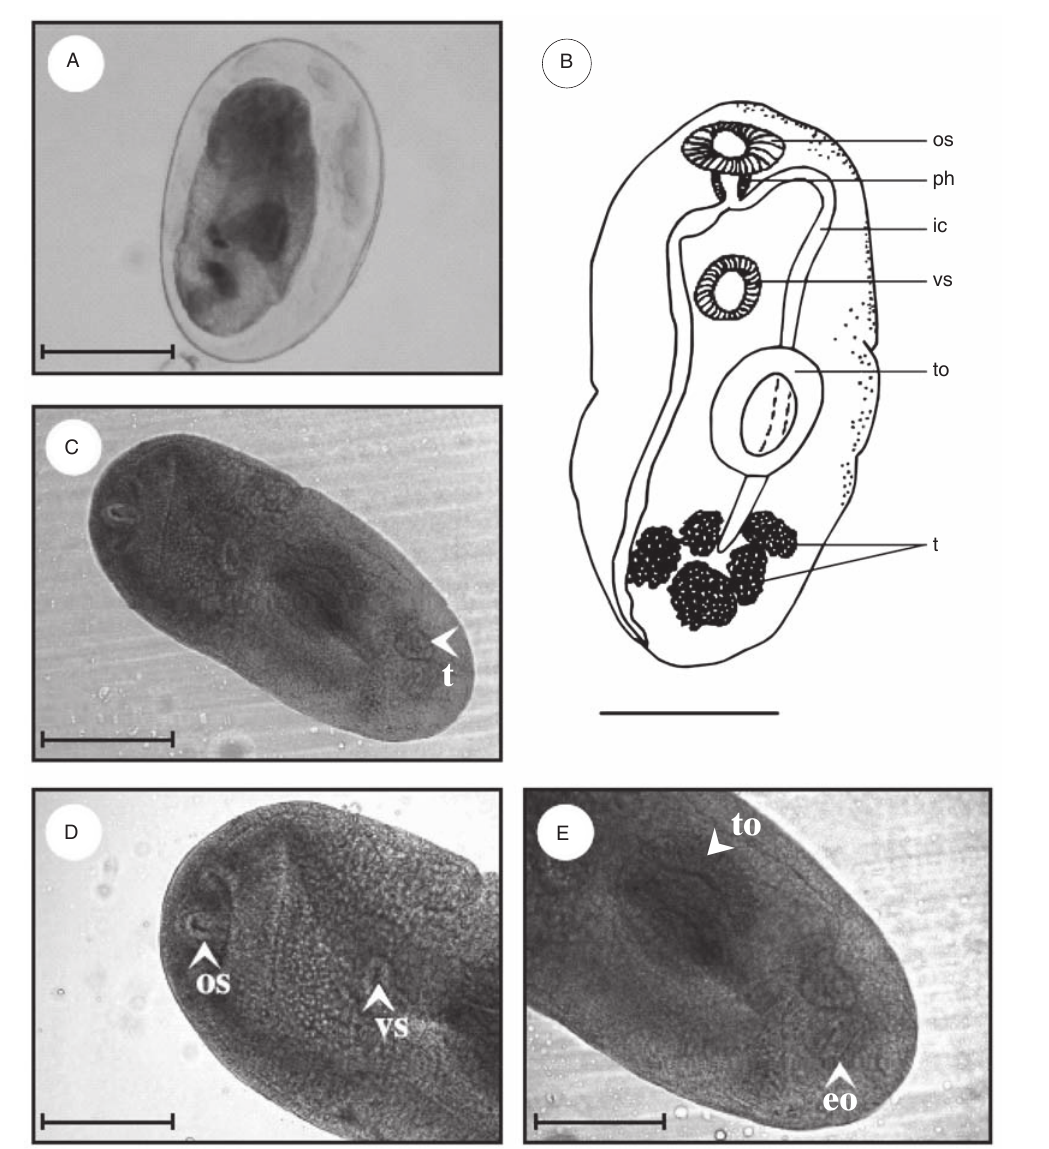
Ornithodiplostomum sp. Metacercariae (A) encysted (scale bar = 400 μ m), (B) drawing showing main features (scale bar = 350 μ m), (C) whole worm (scale bar = 250 μ m), (D) anterior end showing oral sucker and pharynx (left arrow) and ventral sucker (right arrow), (E) posterior end showing rudi- mentary genital/excretory opening (scale bars = 150 μ m), eo = excretory opening, ic = intestinal caecum, os = oral sucker, ph = pharynx, t = testes, to = tribocytic organ, vs =